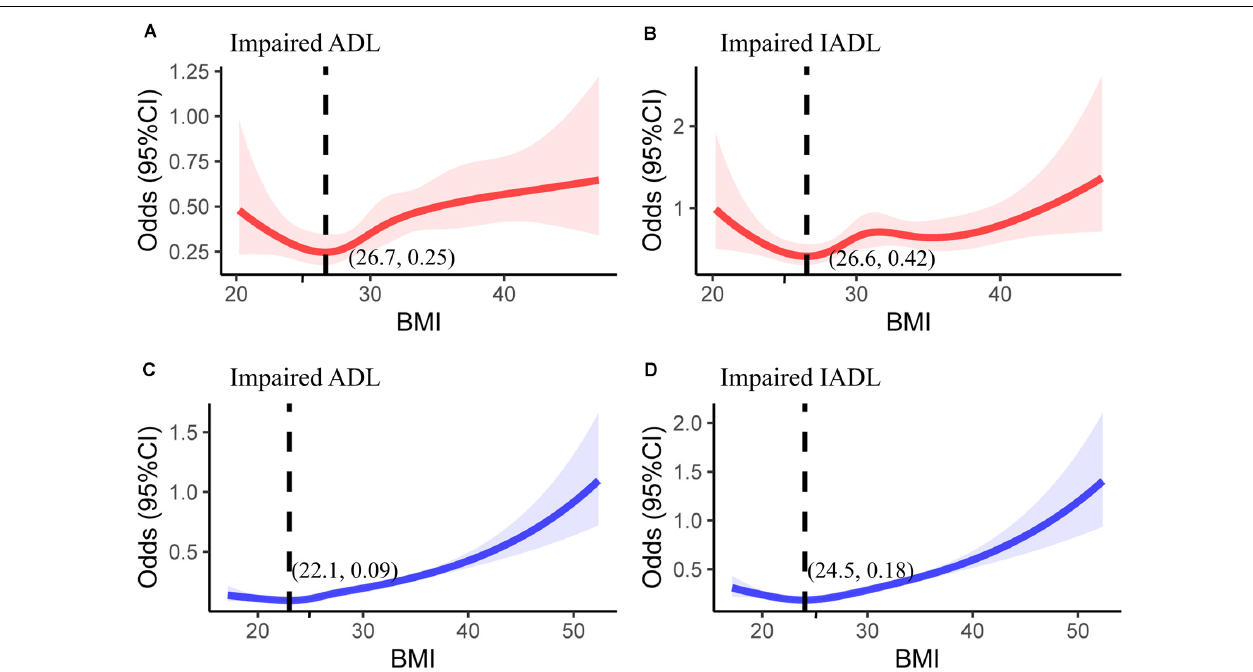
FIGURE 4 | The association between body mass index and odds ratio for impaired (A) activities of daily living (ADLs) and (B) instrumental ADLs (IADLs) in individuals with diabetes. The same relationship was investigated for impaired (C) ADLs and (D) IADLs in individuals with diabetes. The adjusted variables of the logistic regression model are consistent with Figure 3 . CI, confidence interval.